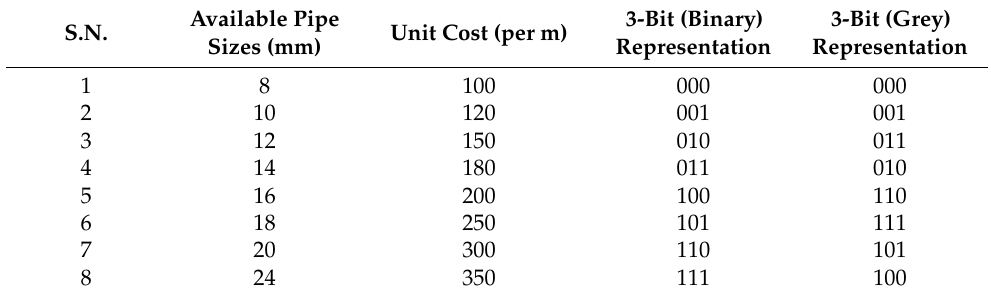
Table 1. Example: Available pipe sizes.